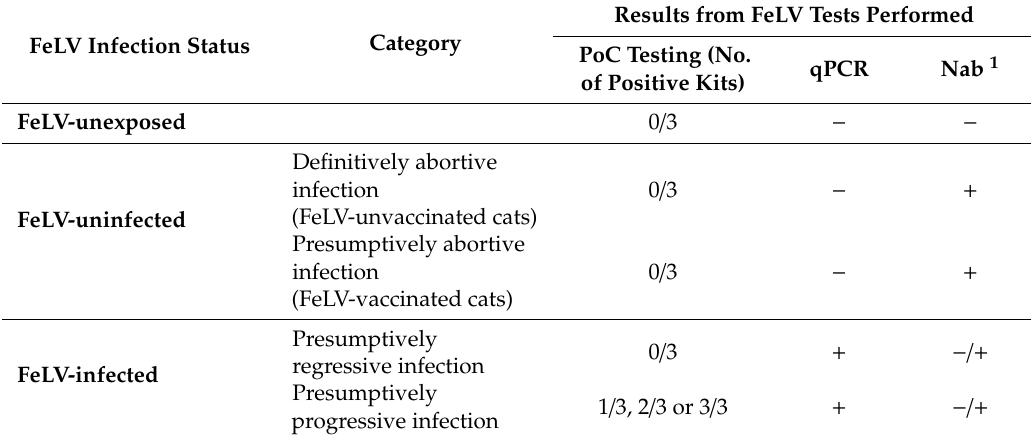
Table 1. Definitions used for defining each cat’s FeLV status in the current study, based on results from the panel of FeLV tests